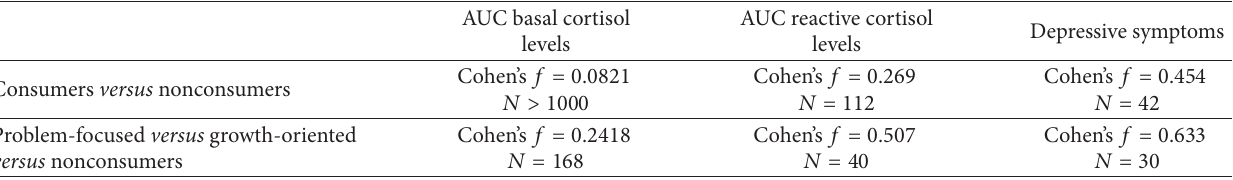
Table1:Cohen’s 𝑓 2 effectsizesforthecomparisonsofbasal/reactivecortisolanddepressivesymptomsbetweenconsumersandnonconsumers of self-help books and between consumers of problem-focused versus growth-oriented self-help books when compared to nonconsumers.